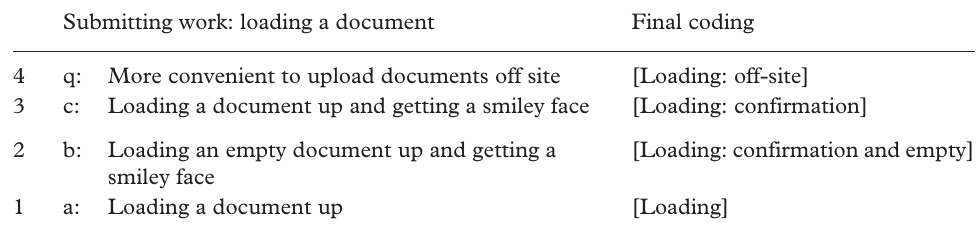
Table 2. Loading a document: sequenced in decreasing levels with structured coding